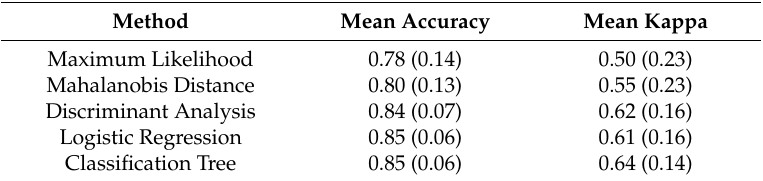
Table 2. Mean overall agreement values and mean Kappa values for the five classification methods compared for the classes flooded and non-flooded. Standard deviation is shown in brackets. Statistics are from the eight Landsat training scenes.